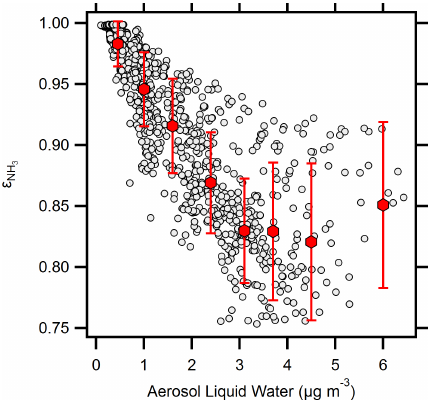
Figure 5. Relationship between NH 3 partitioning = NH + NH + ( ε NH )) and aerosol liquid water. Sym- 3 /(NH 3 4 3 bols represent mean values, while error bars represent standard deviations; bins were limited to a maximum of 160 points per